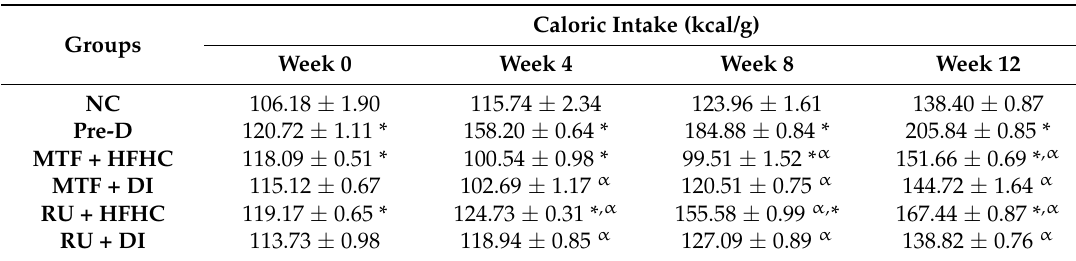
Table 1. Effects of the ruthenium complex on caloric intake of pre-diabetic animals during treatment period. Values are presented as means ± SEM ( n = 6) in each